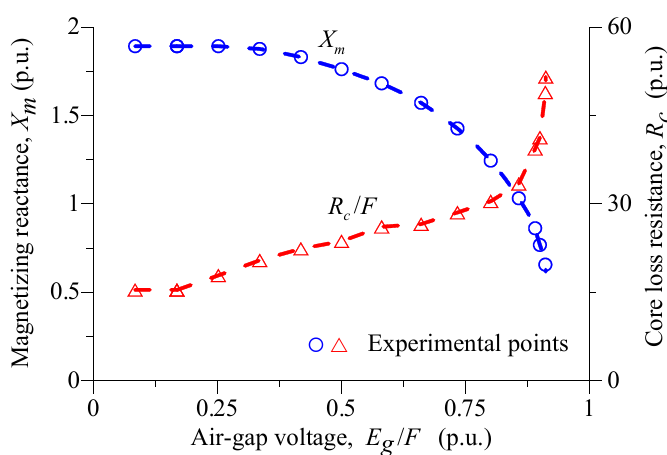
Figure 3. Variation of magnetizing reactance X m and core loss resistance R c / F versus air-gap voltage E g / F in the machine under study.